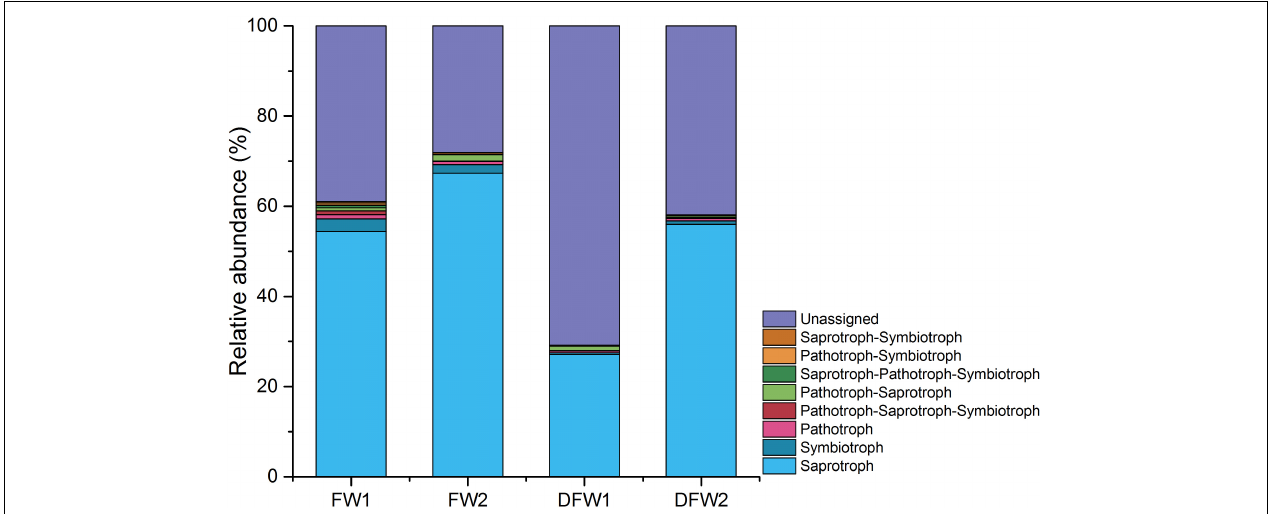
FIGURE 3 | The relative abundance of fungal trophic modes in 0–5 and 5–10 cm soils of FW and DFW. (Note: 1 represents 0–5 cm soils and 2 represents 5–10 cm